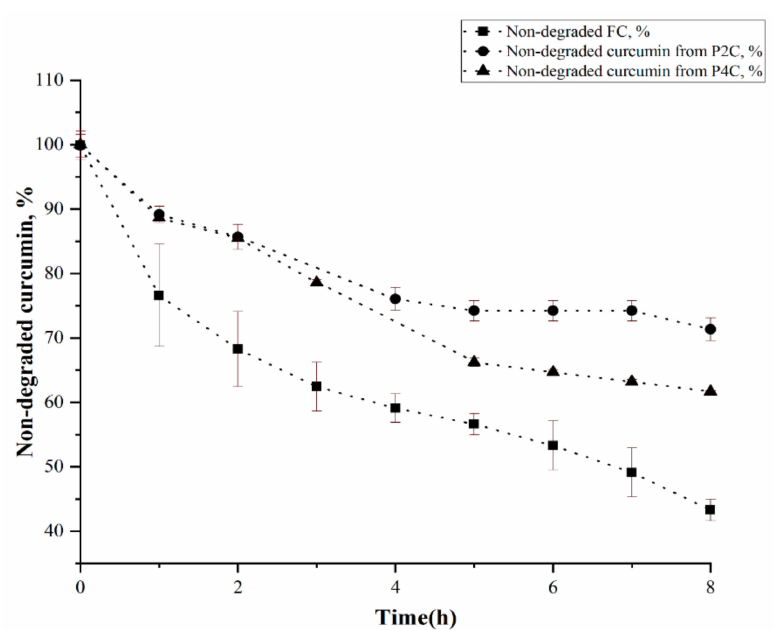
Figure 7. Variation in time in the amount of undegraded curcumin at pH 6.8 for free curcumin and curcumin extracted from P2C ComPs or P4C